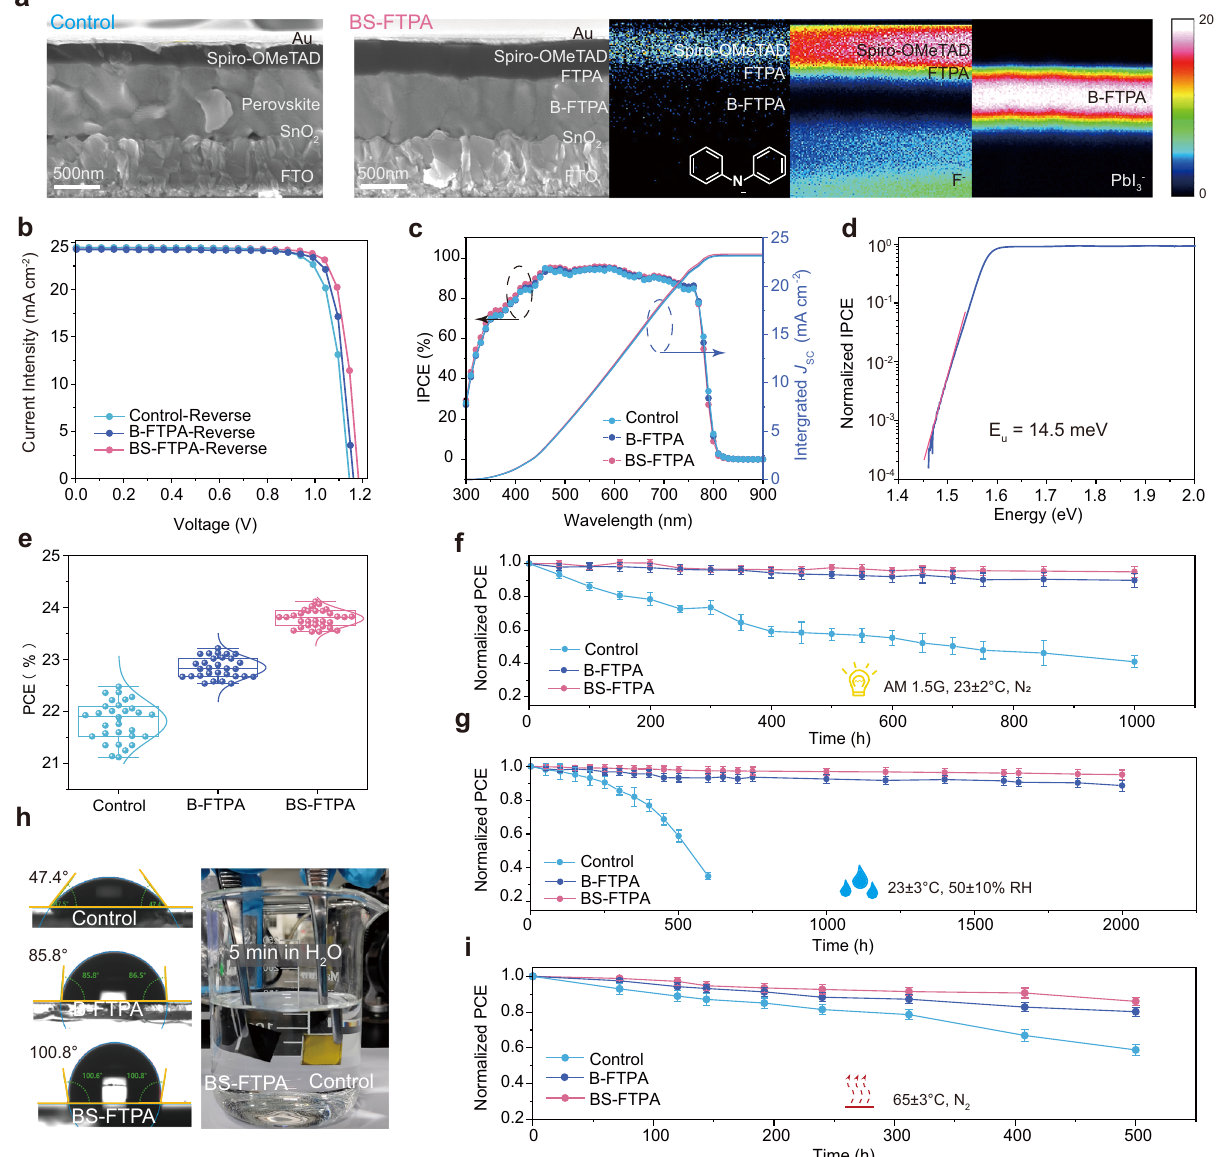
Fig. 4 | Photovoltaic characteristics and stability of PSCs based on control, B-FTPA and BS-FTPA. a A cross-sectional SEM images showed the device archi- tectures: FTO/SnO 2 /perovskite/Spiro-OMeTAD/Au for control, FTO/SnO 2 /B-FPTA perovskite(withFTPA43.13mgmL − 1 inthebulk)/FTPA(2mgmL − 1 )/Spiro-OMeTAD/ AuforBS-FTPA;ToF-SIMScross-sectionimagespresentedtheelementdistribution inBS-FTPA.C 12 H 10 N - signalsattributedtothediphenylaminebranchesofFTPAand Spiro-OMeTAD; F - signals corresponding to the Li-TFSI in Spiro-OMeTAD solution, FTPAinbulkandsurfaceofperovskite,andFTO;thePbI 3 - signalscorrespondingto the perovskite. b J - V curves of the champion PSCs. c IPCE spectra of the devices integratedovertheAM1.5G(100mWcm − 2 )solarspectrum. d SemilogplotofIPCE